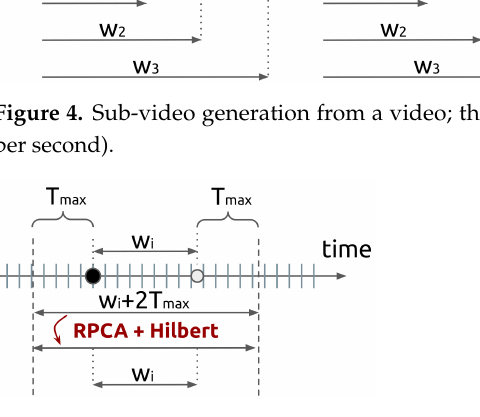
Figure 5. RPCA + Hilbert transform of the sub-videos.